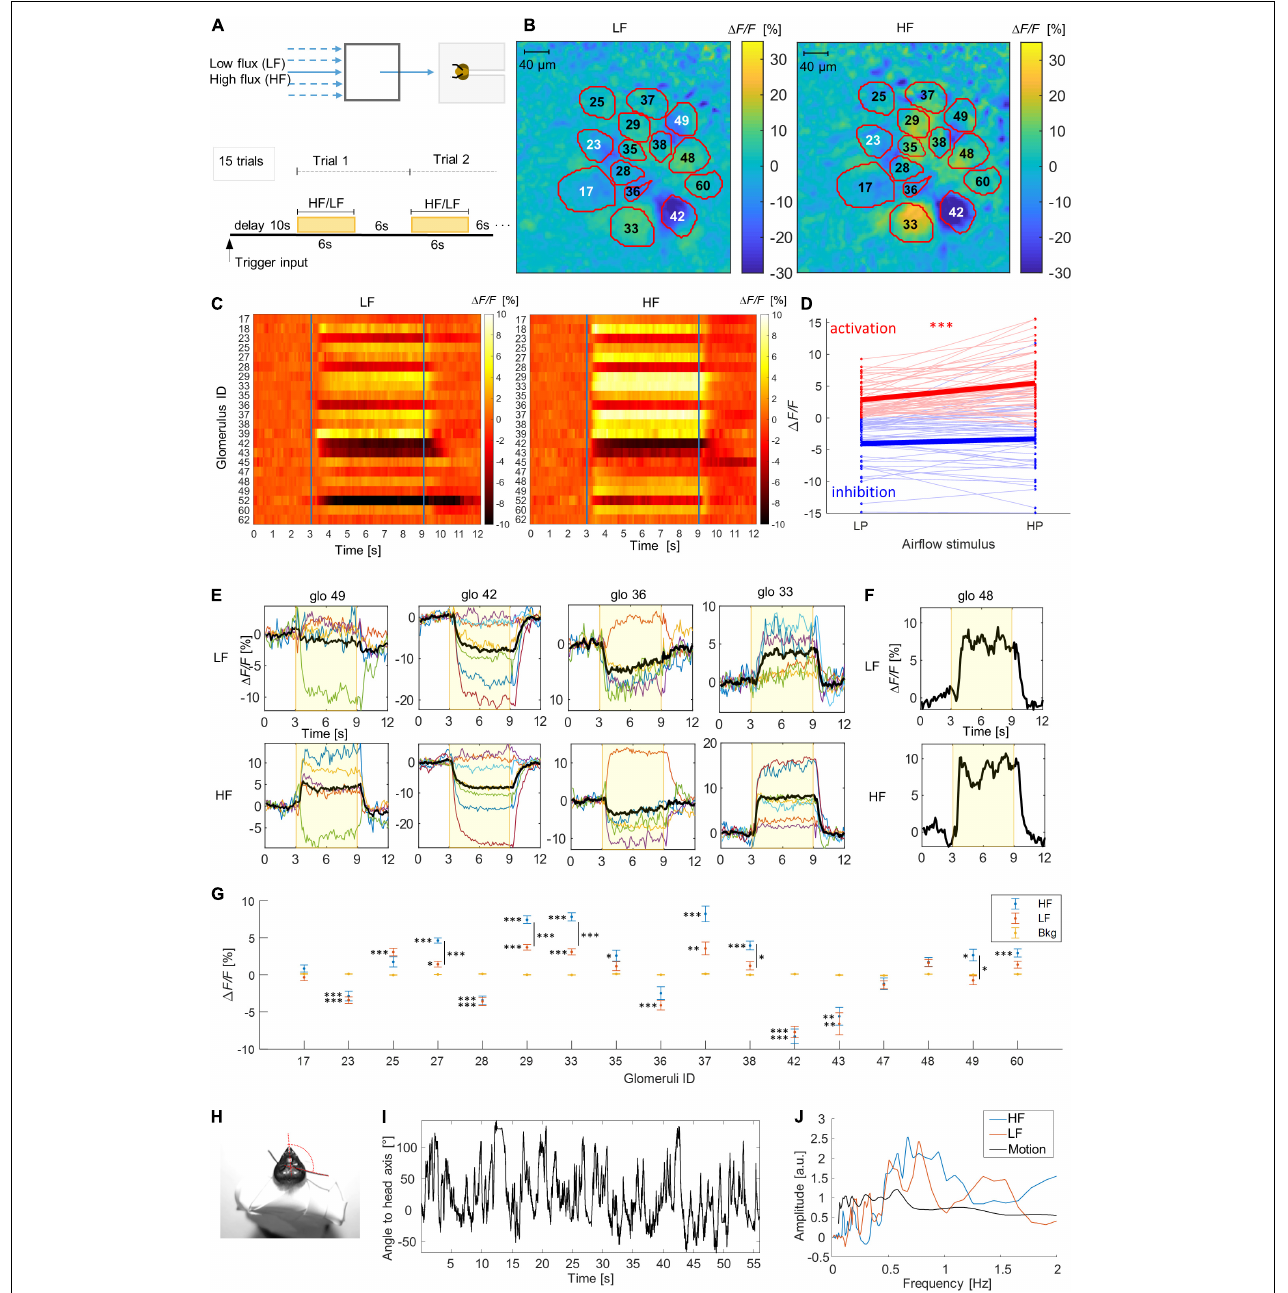
FIGURE 1 | Response patterns to airflow stimuli. (A) Setup scheme and stimulus protocol. Stimuli start after 10 s of background acquisition, lasting 6 s (yellow area), inter-trial distance 6 s. (B) Example for the relative fluorescence change ( (cid:49) F / F [%]) in the imaging plane across the AL. Outlines and labels show the identified glomeruli. (C) Heatmaps show subject-averaged ( N = 7) responses of all imaged glomerulus to low flux (LF) and high flux (HF) delivered after 3 s. (D) Change of the glomerular activation between LF and HF, activated glomeruli (red dots) increase responses significantly [paired t -test: t (56) = –5.51, p = 10 - 7 ], inhibited glomeruli (blue dots) don’t [ t (49) = –1.65, p = 0.11]. (E) Temporal response curves of four selected glomeruli to LF and HF airflow. Colored curves show single subject responses, averaged over 15 trials. The black curve is the subject-averaged response. The yellow background marks the stimulus interval. (F) Example of glomeruli showing an oscillatory modulation of the activity signal. (G) Glomerular response amplitudes during the central 3 s of stimuli with different airflow intensities. Shown are mean values and standard errors across all trials of all bees (blue: high flux, red: low flux, yellow: background signal). Significant differences with respect to the background are marked with ∗ p < 0.05, ∗∗ p < 0.01, ∗∗∗ p < 0.001. Significant differences between different flux velocity responses are marked with an additional vertical bar. Full statistical results are shown in Supplementary Table 2 . (H) Bee mounted with the head and the antennae free to move for high-speed antenna motion imaging, current angle of the right flagellum is marked in red. (I) Example for an antenna tracking curve during 1 min of recording. (J) Averaged spectra of the oscillatory activity in panel (F) (red LF, blue HF) and spectrum of the antenna motion in panel (I) .